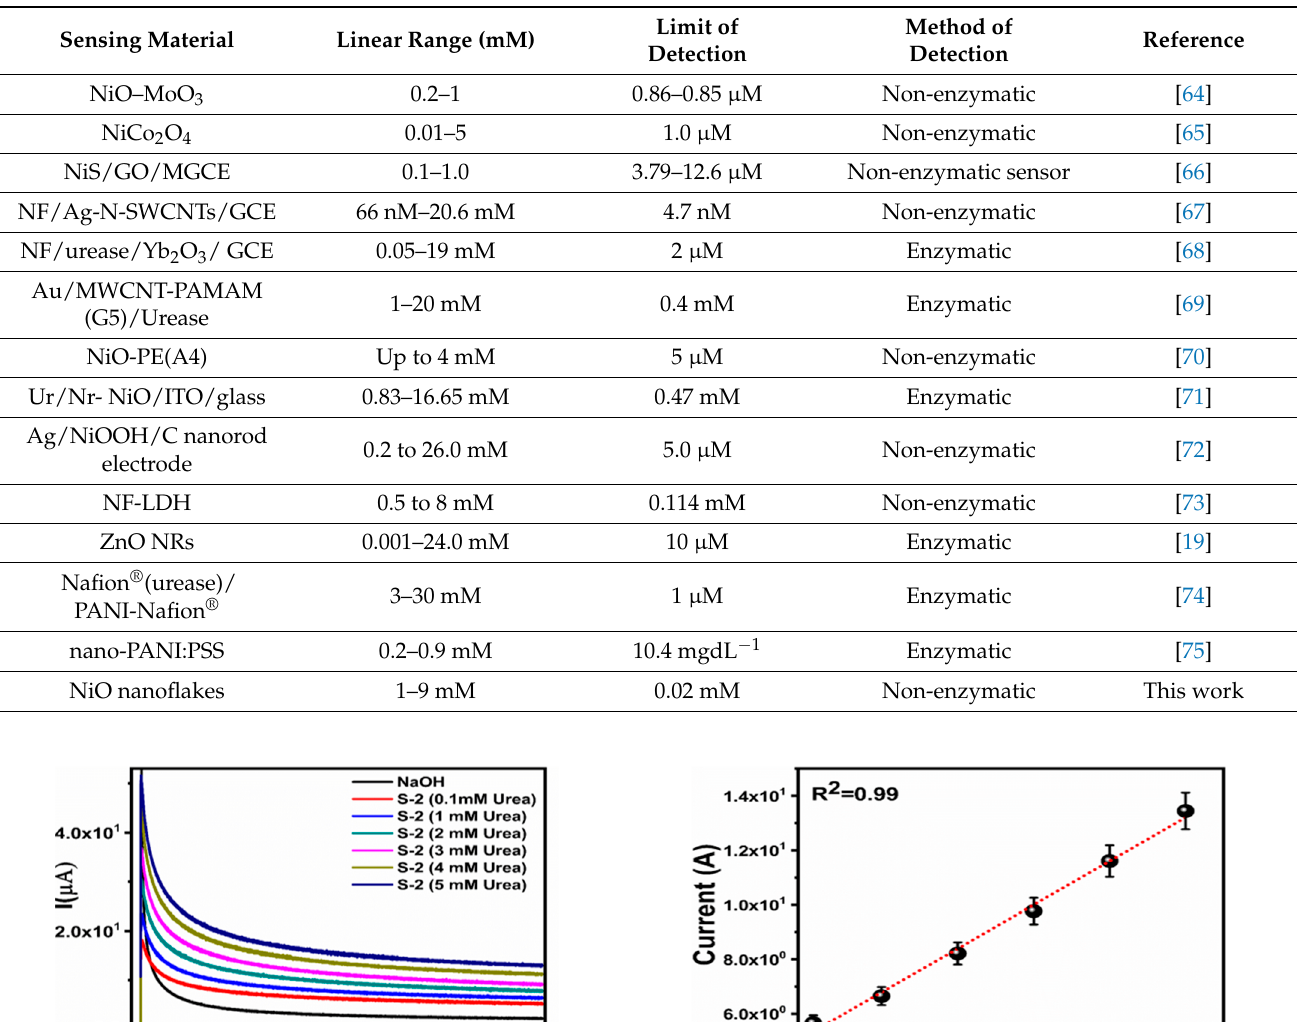
Table 2. Comparison of proposed non-enzymatic urea sensor performance with the reported works.